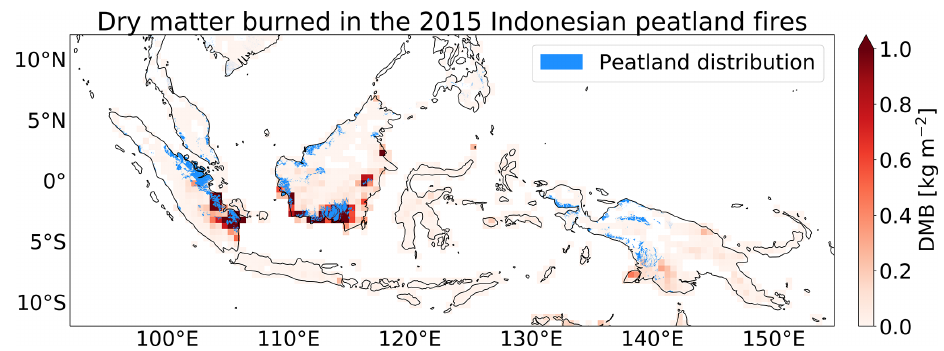
Figure 1. Accumulated dry matter burned (DMB) during the Indonesian peatland fires of 2015. The distribution of Indonesian peatland is indicated in blue. The data for the peatland distribution are obtained from Xu et al. (2017,